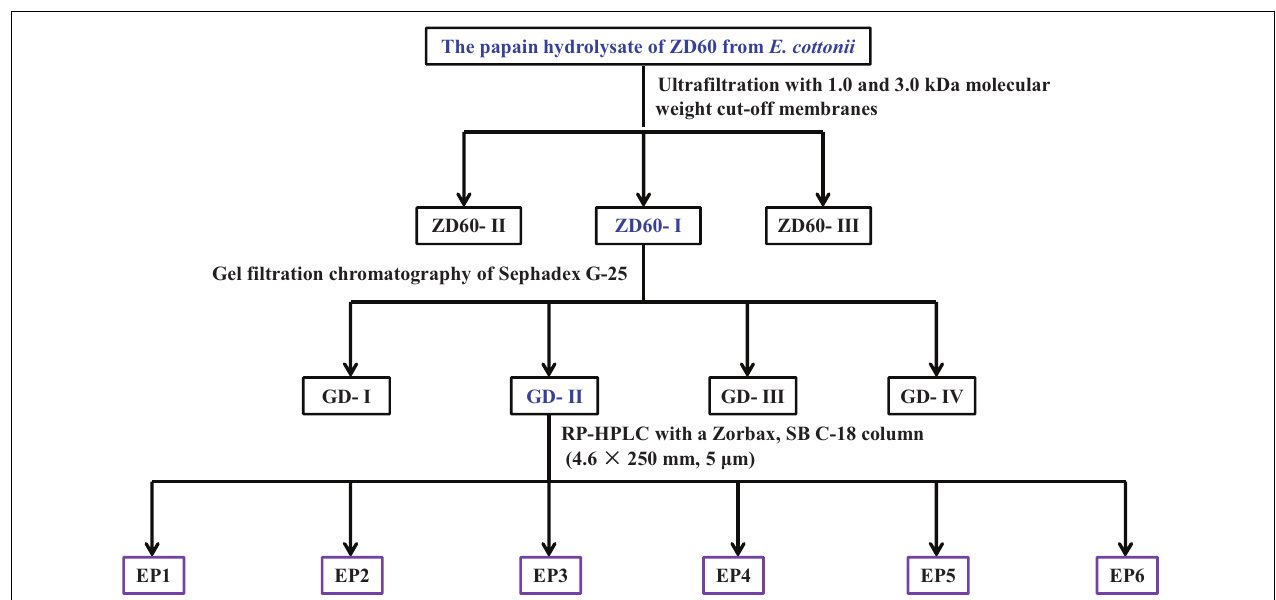
FIGURE 1 | The flow diagram of isolating antioxidant peptides from the papain hydrolysate of ZD60 [proteins precipitated using 60% (NH 4 ) 2 SO 4 ].